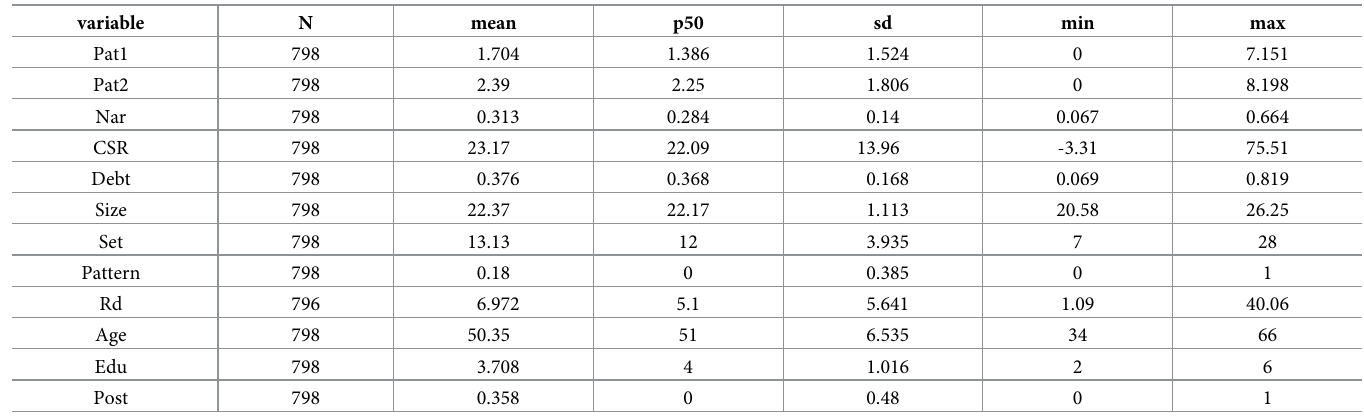
Table 3. Descriptive statistics for primary variables.